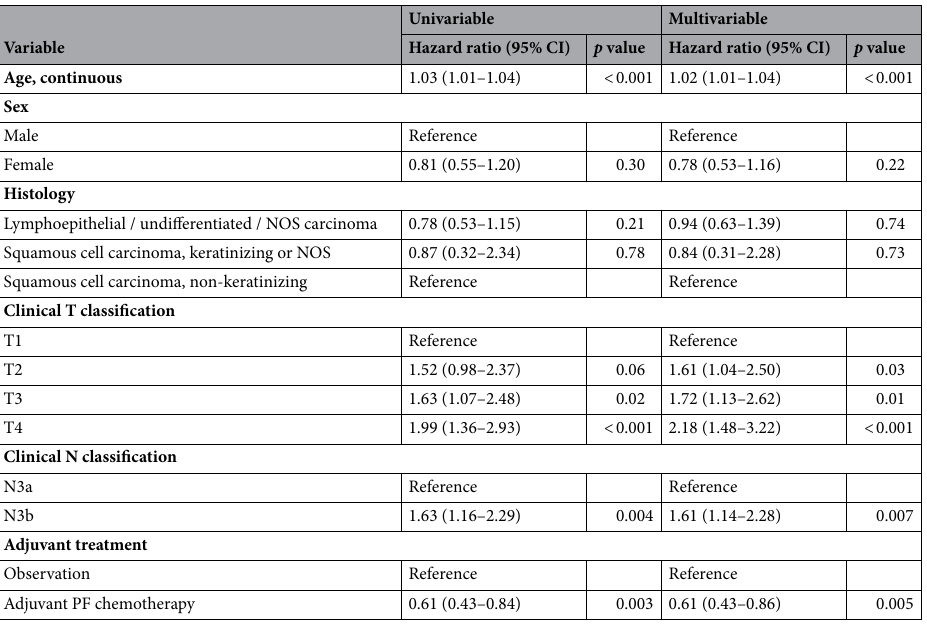
Table 2. Univariable and multivariable Cox proportional hazards model for overall survival (n = 431). CI, confidence interval; NOS, not otherwise